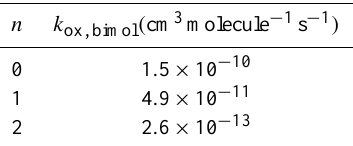
Table 2. Bimolecular rate constant ( k ox, bimol ) of the SO 2 + benchmarking (Table 1) suggests that these values are more likely to be underestimated than